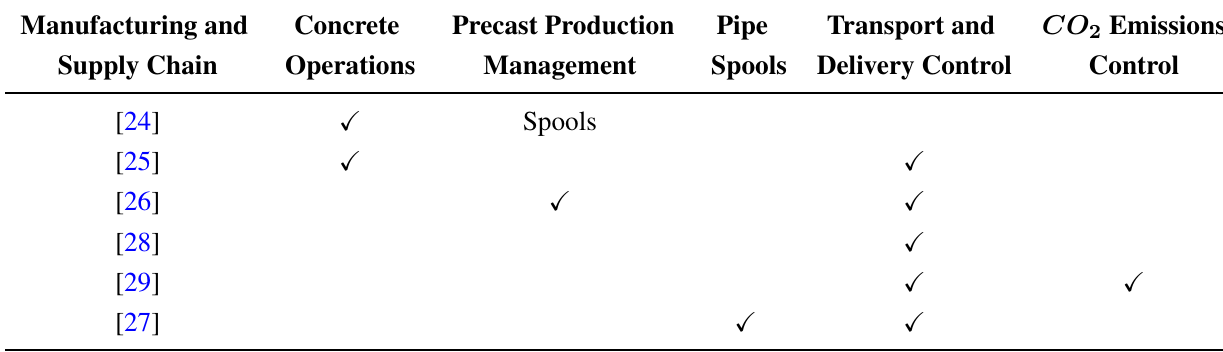
Table 4. Different solutions for manufacturing control with